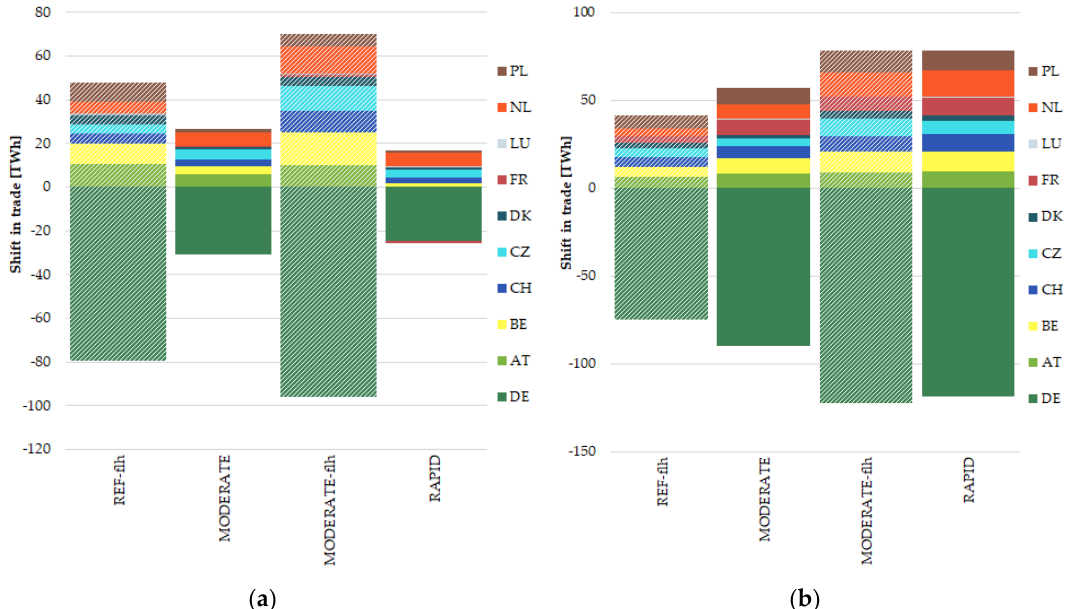
Figure 7. Shift in of the trade accounts of central European countries in 2020 ( a ) and 2030 ( b ) relative to base case (own depiction).